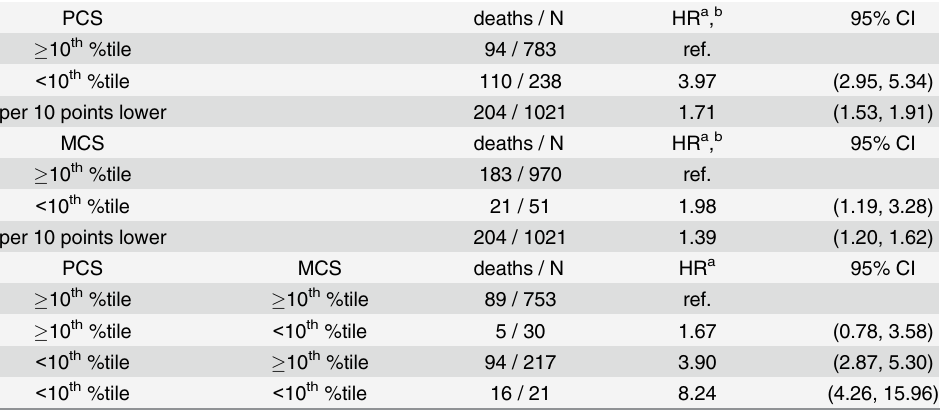
Table 3. Association of subsequent survival with quality of life Physical Component Summary (PCS) and Mental Component Summary (MCS) score assessed approximately 5 years after colorectal can- cer